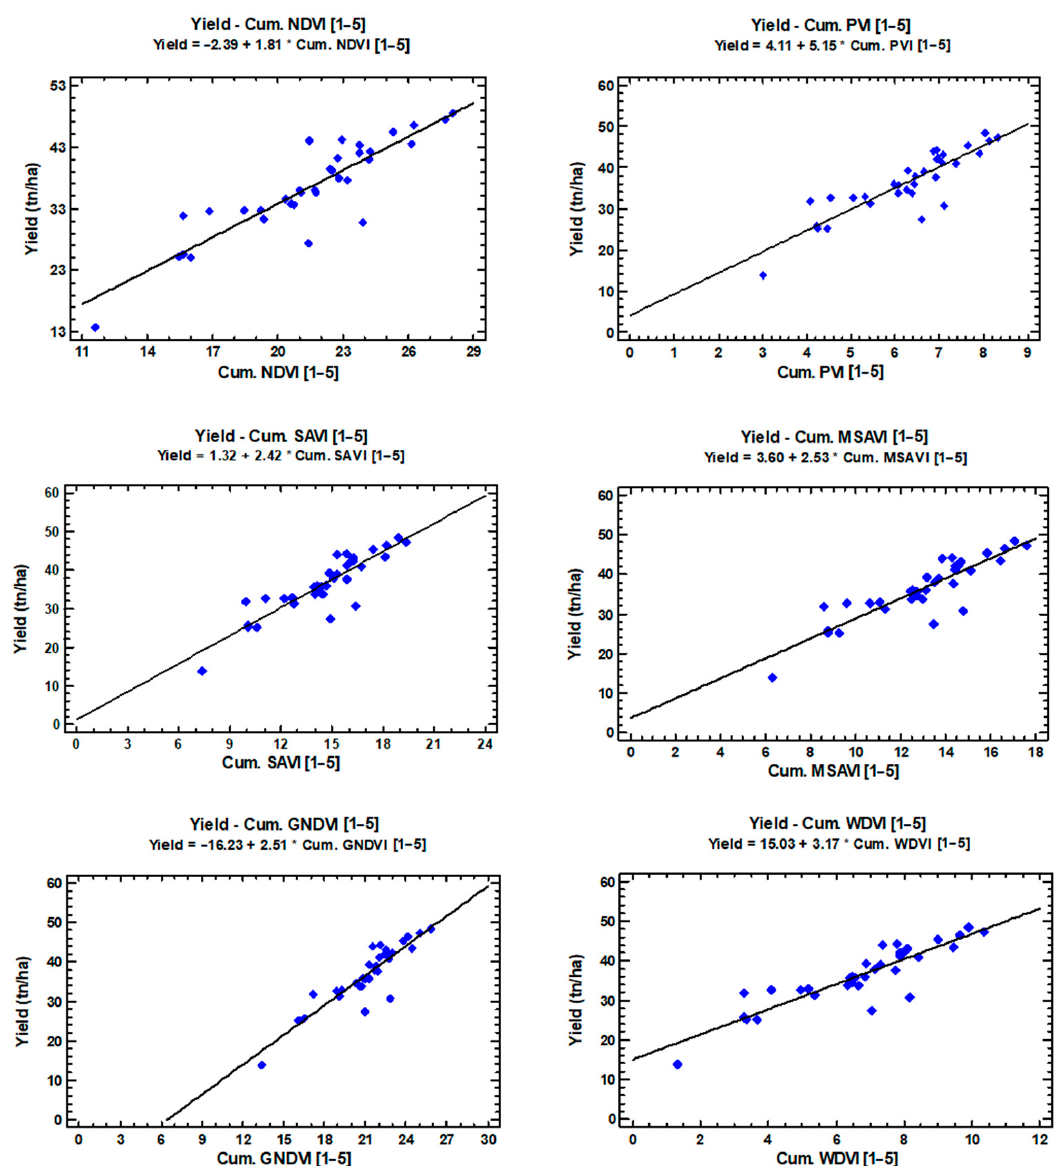
Figure 8. The linear regression model that describes the relationship between the total cumulative VI range values and the corresponding recorded yield across all pilot fields.